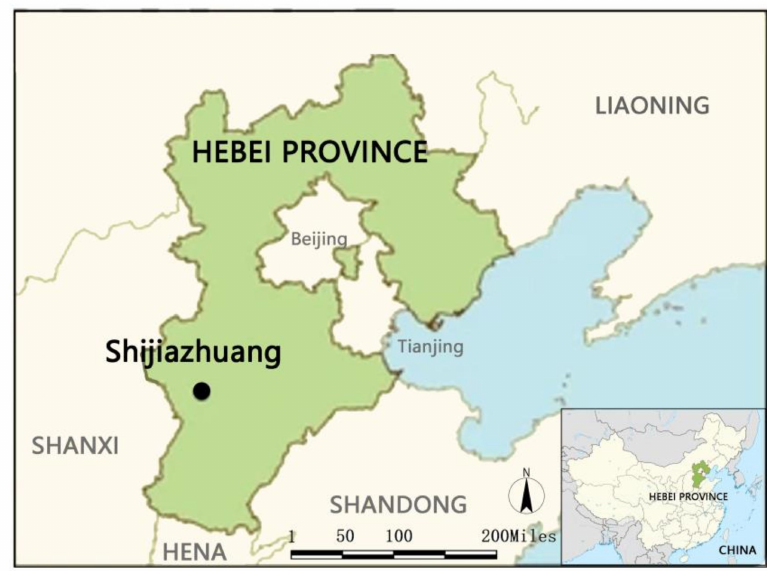
Figure 1. The location of Shijiazhuang, Hebei Province,